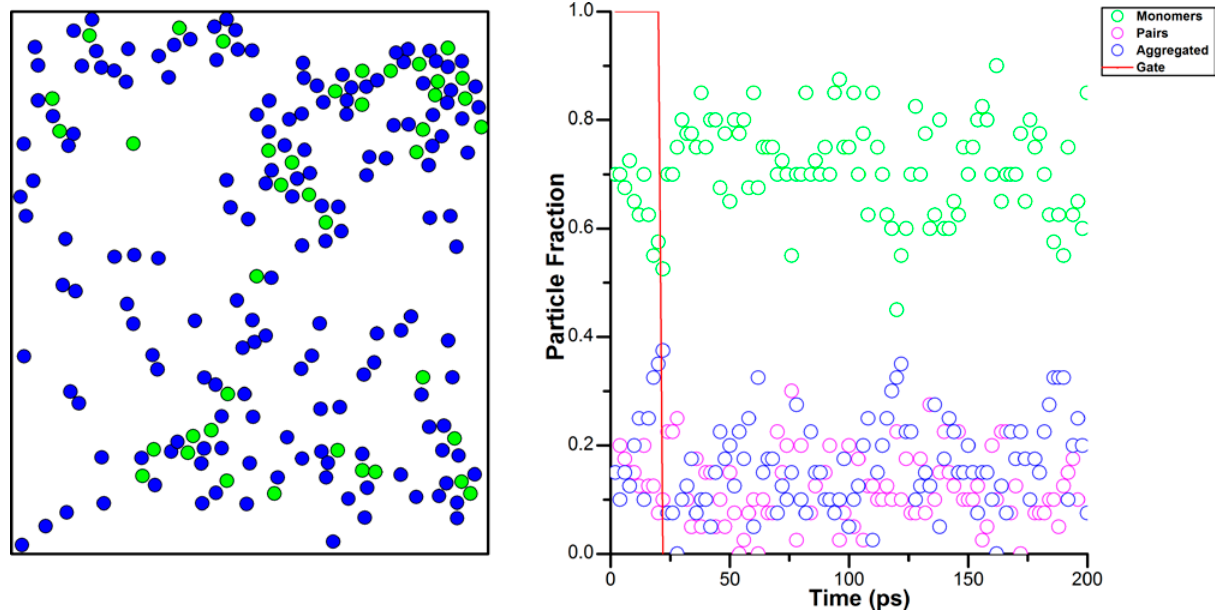
Figure 6. Left: snapshot of the configuration obtained after 200 ps of a simulation for the mixture described in Figure 3 at T = 300 K. The interaction parameters (eV) were: ɛ A-A = 0.01, ɛ B-B = 0.05 and ɛ A-B = 0.1. Right: time evolution of the fraction of B monomers, pairs of B atoms and total aggregated B atoms present in clusters of more than 2 B atoms for the same simulation. The time at which the red line sharply drops to zero indicates when the gate shown in Figure 3 was opened and the particles were allowed to mix. The MD time step was 1